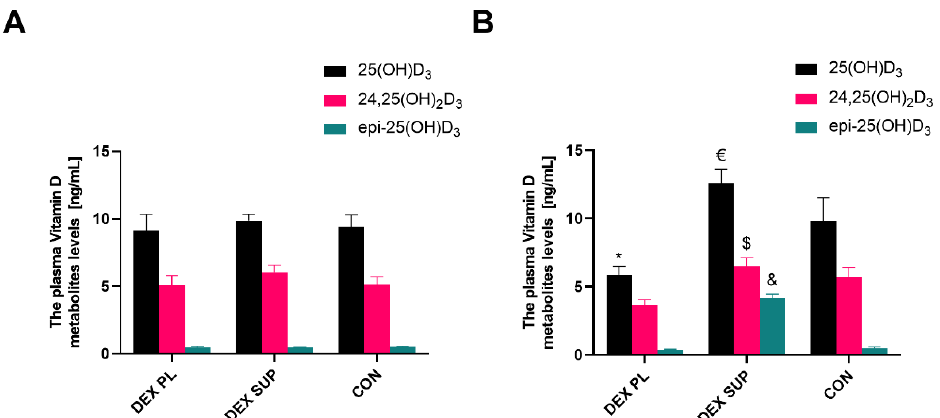
Figure 2. The plasma vitamin D metabolite levels in DEX-treated rats at baseline ( A ) and the end of the experiment ( B ). Results are expressed as mean ± SEM. DEX PL ( n = 7), DEX SUP ( n = 8), CON ( n = 6), * p < 0.05 vs. CON, $ p < 0.01 vs. DEX PL, € p < 0.001 vs. DEX PL, & p < 0.0001 vs. DEX PL; vs. CON. DEX PL: dexamethasone-treated group supplemented with placebo; DEX SUP: dexamethasone-treated group supplemented with vitamin D 3 ; CON: control group.